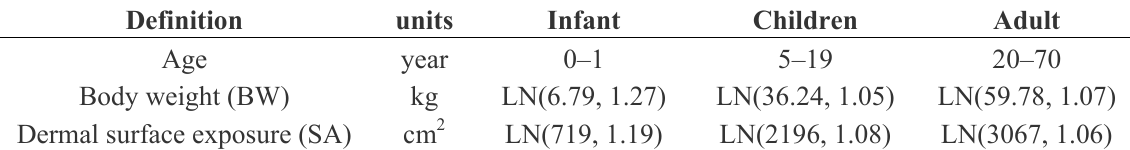
Table 3. Risk parameters considered as random variables (lognormal distribution with geometric mean and geometric stand deviation: LN (gm, gsd)) for different age groups